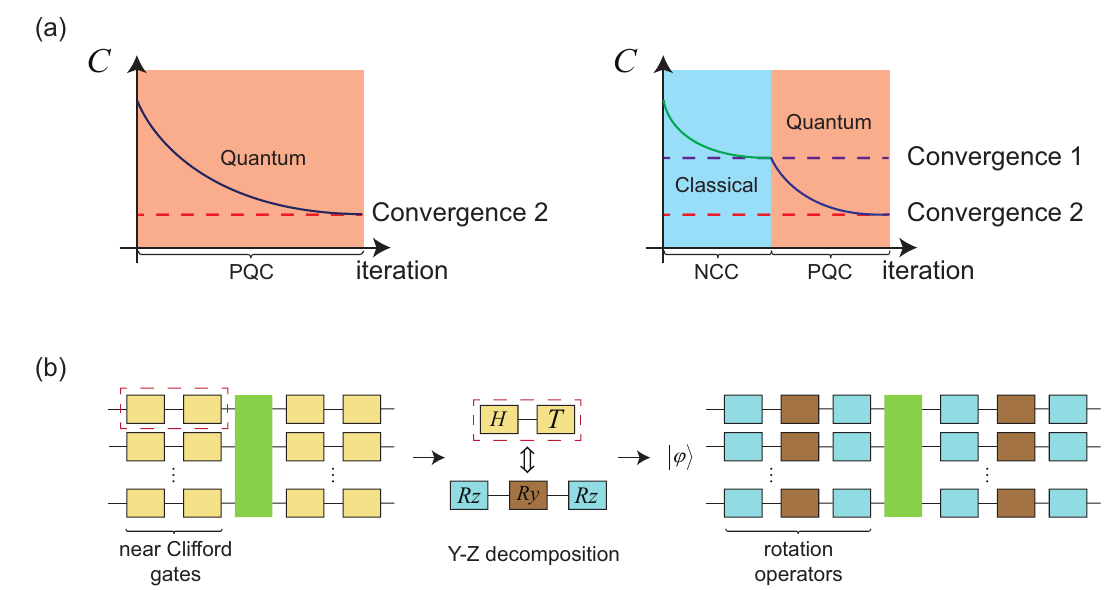
Figure 1. Schematic diagram of NCC-WS. ( a ) Left: A diagram of the training process of conventional VQAs with random initialization parameters. The cost function C gradually converges to the optimum with iterations. Right: A diagram showing the application of NCC-WS before the second-stage VQAs training. The cost function C associated with machine learning task first converges once after NCC- WS, which is performed by a classical computer. The optimal circuit obtained from NCC-WS is then transformed into a PQC with the same structure. On this basis, the cost function C reaches a new convergence due to the improved expressivity of PQC, which is performed by a quantum computer. Compared with conventional VQAs, the training of VQAs after NCC-WS is initialized with better parameters so that fewer iterations are needed to achieve the same or even better training results, where the cost of NCC-WS is negligible. ( b ) The process of converting an NCC into an equivalent PQC with the same structure as the